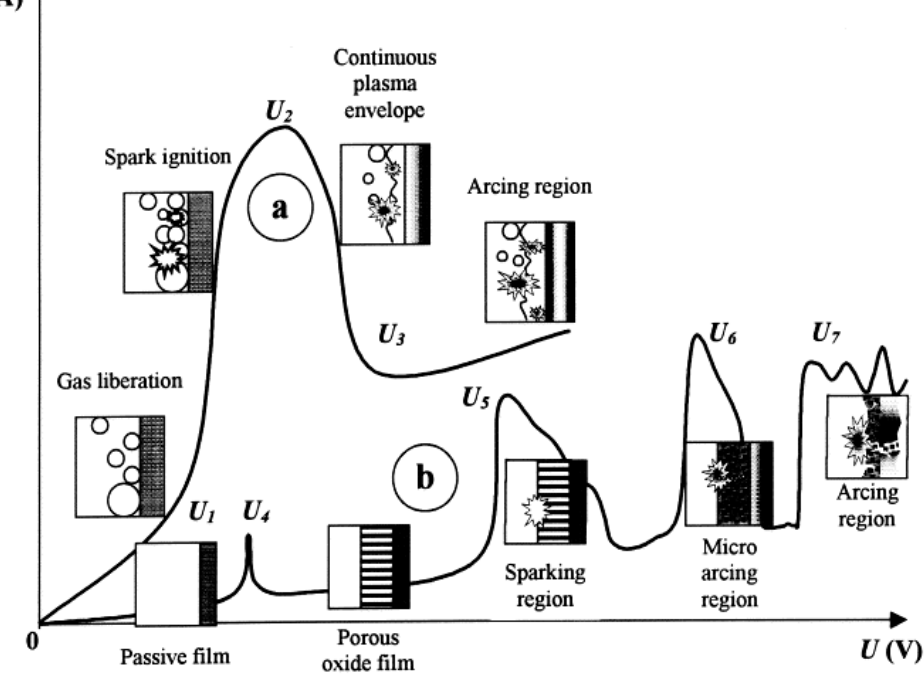
Figure 2. Schematic of current–voltage diagram with the corresponding metal oxide film formation steps during plasma electrolytic oxidation treatment ( a ) in the near-electrode area and ( b ) in the dielectric film on the electrode surface. Reprinted from [10] with permission from Elsevier.